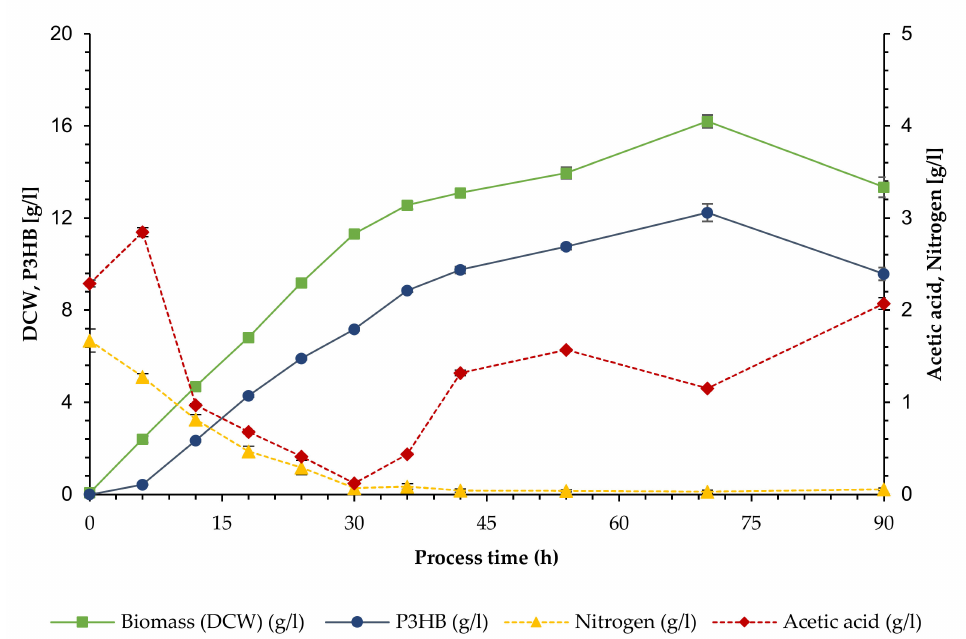
Figure 3. Cultivation of Bacillus megaterium uyuni S29 in a cell recycle process (II, replicate). Biomass (as DCW) and polymer (P3HB) concentration (left axis) and concentration of acetic acid and nitrogen (as TKN) (right axis). Error bars represent standard deviation from triplicate